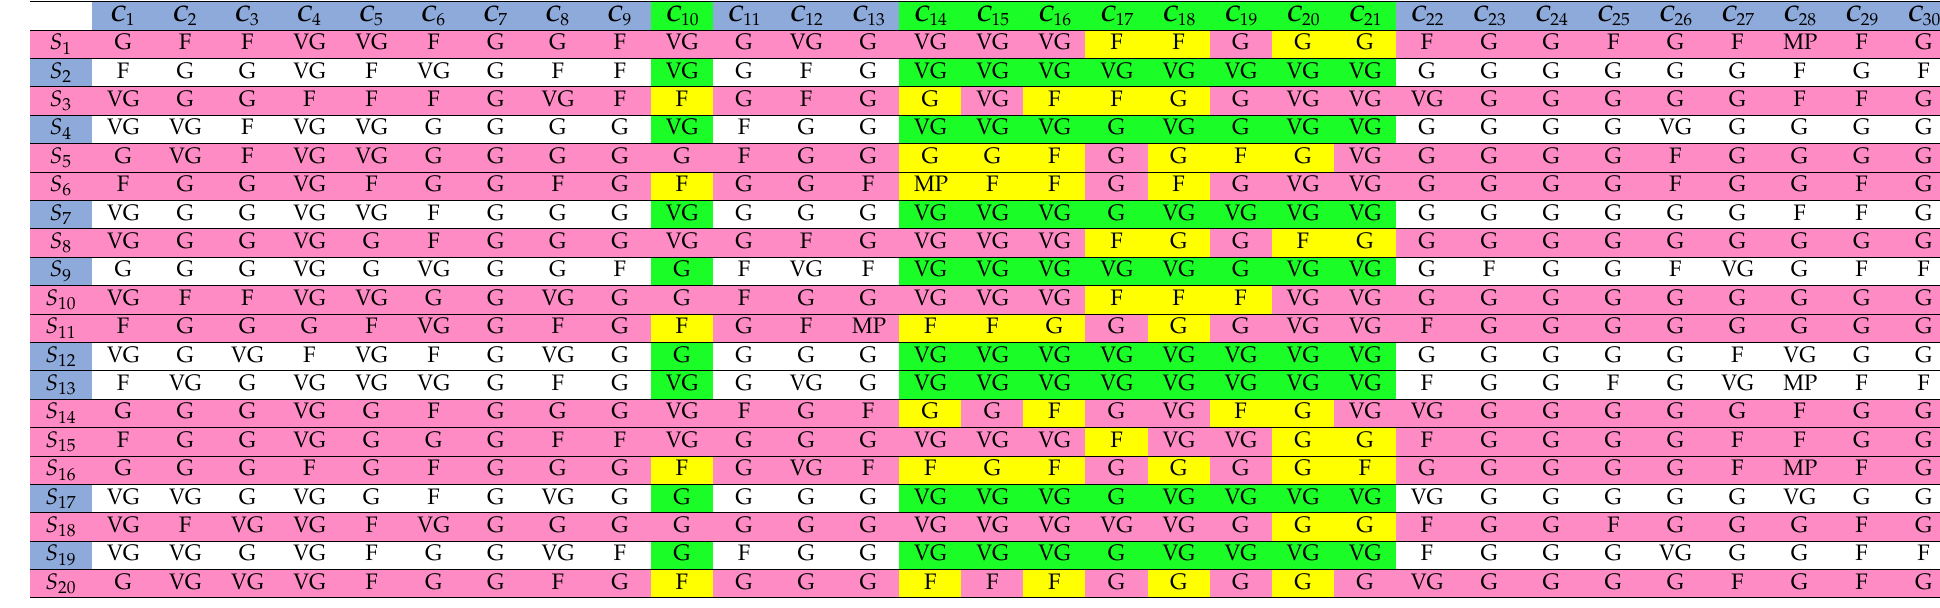
Table 11. The evaluation of selected suppliers with ( S ∗